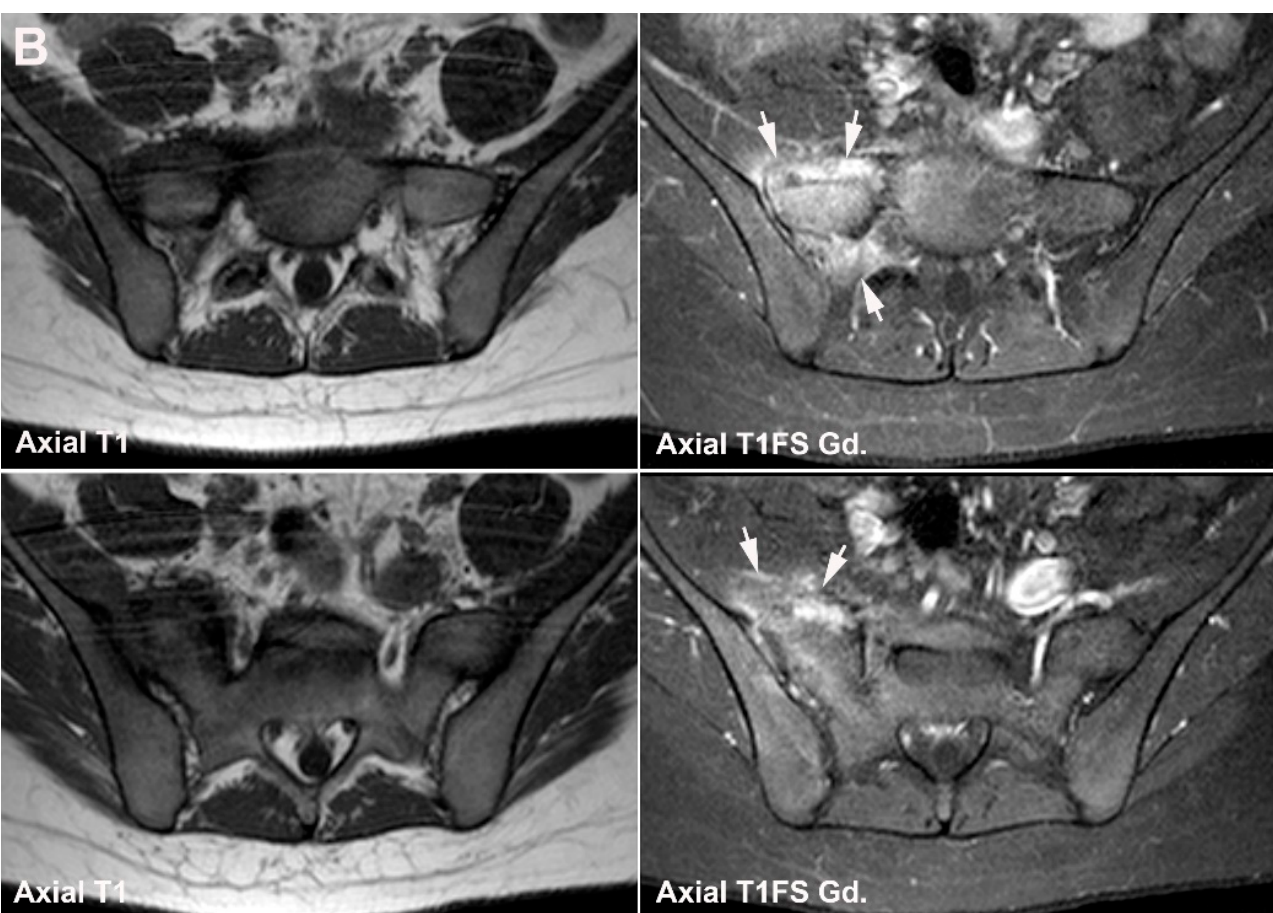
Figure 28. CNO in adulthood (SAPHO— Synovitis, Acne, Pustulosis, Hyperostosis), MRI in a 35-year-old woman with intermittent flares of low back pain since the age of 19 years. ( A ) MRI at the age of 35 years during a flare, semi-coronal T1, T1FS and STIR, and semi-axial STIR showing changes confined to the sacral bone in the form of right-sided sacral hyperostosis with manifest fat metaplasia in the bone marrow accompanied by discrete fat metaplasia in the sacrum at the intervertebral (iv) space L5/S1 (arrows), signs of previous osseous inflammation. There is discrete subchondral BME in S2, but the most manifest sign of activity is in the subchondral bone in L5 at the iv space L5/S1 (arrowheads). ( B ) MRI at the age of 19 years, axial T1, and postcontrast T1FS at the level of S1 (upper image row) and upper part of S2, showed manifest inflammation in the sacral bone with enhancement in the adjacent soft tissue (arrows), changes simulating tumor, but biopsy revealed non-specific subacute inflammatory changes and negative cultures.